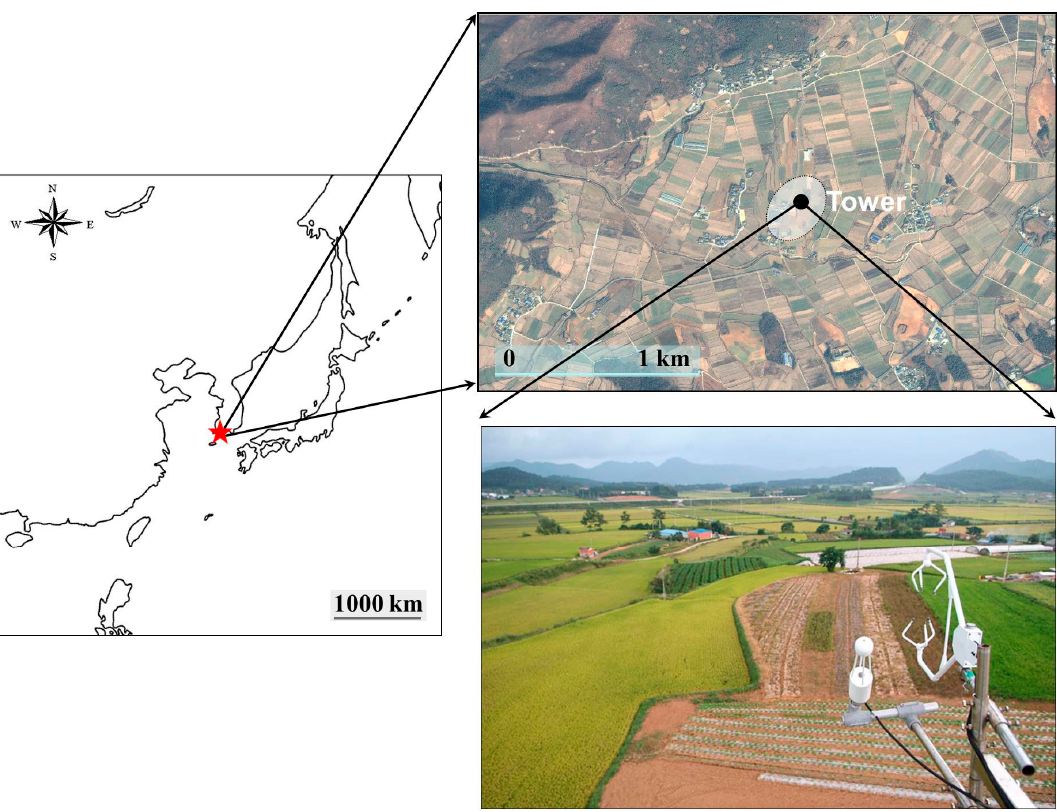
Figure 2. Location of the study site. The shaded area around the tower indicates the effective flux footprint measured by the eddy covariance system (adapted from Kang et al. [10]).